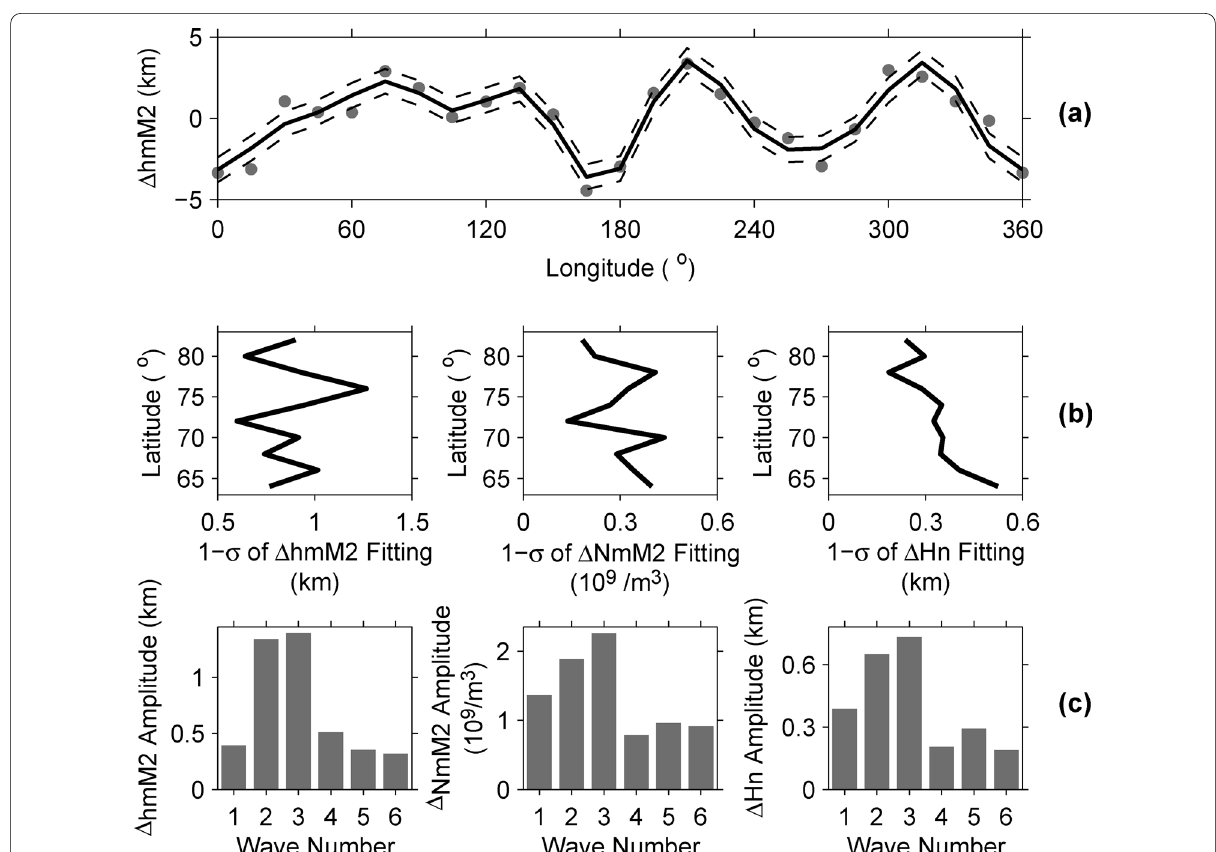
Fig. 4 Analysis for the longitude wave components of h m M 2 , N m M 2 , and H n . a shows longitude variation of the △ h m M 2 at 64°N. The gray dots are gridded △ h m M 2 ; the solid line is the Fourier fitting; the dashed lines indicate the corresponding 1-σ error. b presents latitude variations of the 1-σ errors of △ h m M 2 , △ N m M 2 , and △ H n fittings. c is latitudinally averaged amplitudes of the longitude wave △ H